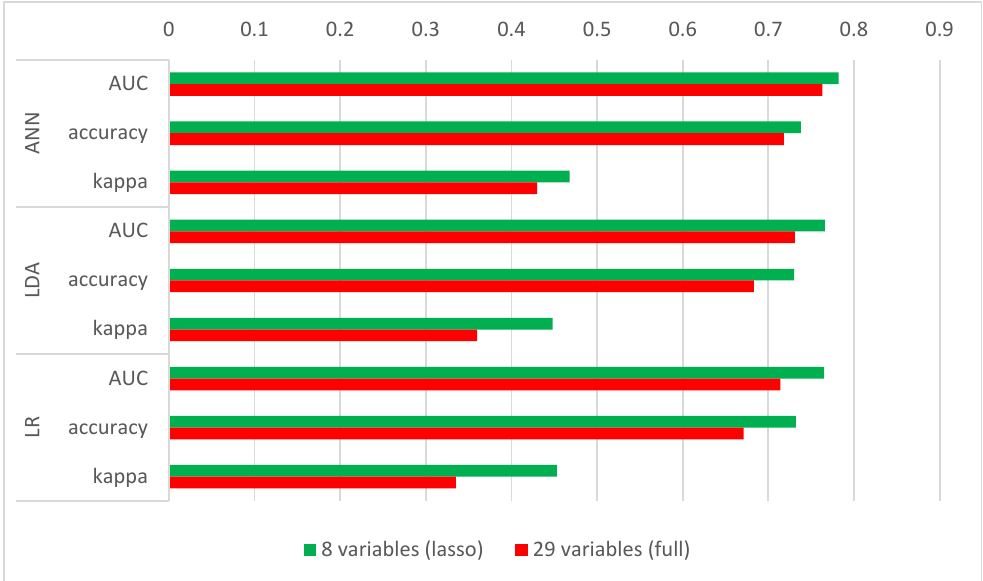
Figure 6. The graphical comparison of model performance shows an increase in all measured parameters for the models trained on the dataset to which LASSO was applied.